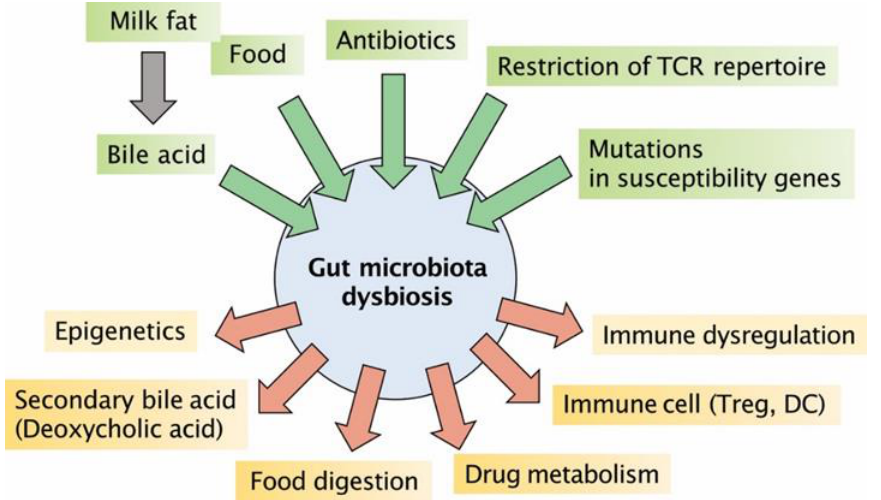
Figure 1. Factors influencing gut microbiota dysbiosis: Milk fat of animal origin, food, antibiotics, the presence of T cells expressing only a restricted number of TCR repertoires, and mutations in susceptibility genes have been shown to be factors that affect dysbiosis of the gut microbiota. The changes in the intestinal bacterial layer caused by these various factors are closely related to secondary bile acids produced by metabolism by gut microbiota, epigenetics, metabolism of dietary fibers and drugs, and differentiation and dysregulation of immune cells. DC, dendritic cells; TCR, T cell receptor.